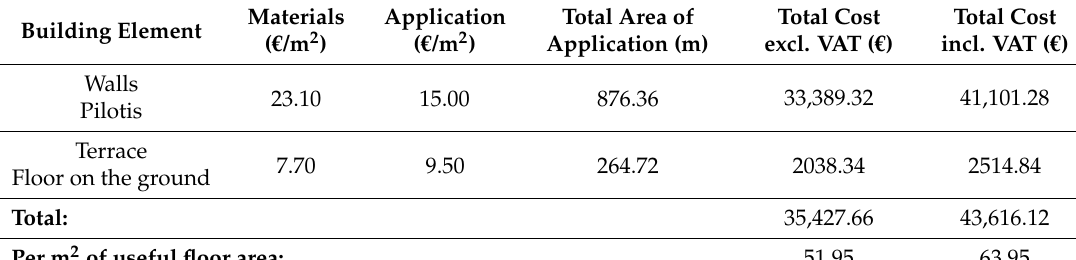
Table A3. Example of initial cost calculation for the 7 cm insulation scenario, with and without taxes.